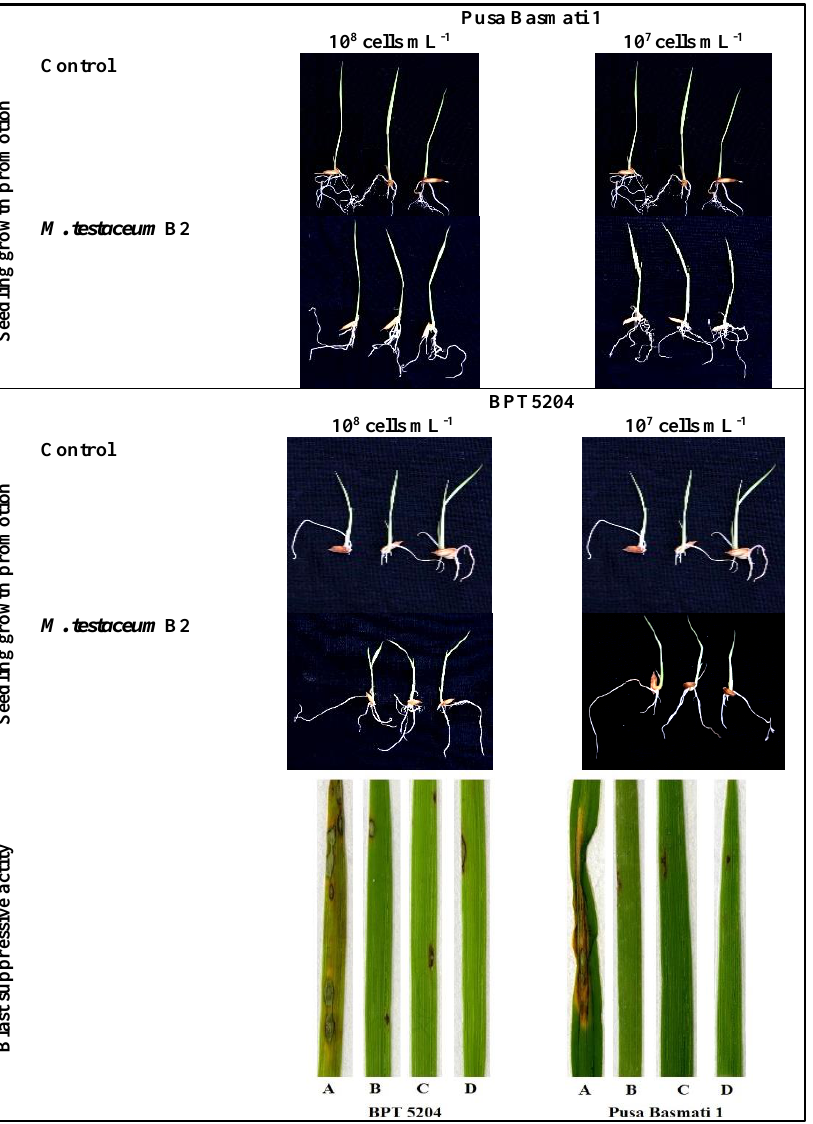
Figure 5. M. testaceum B2 induced growth promotion in rice seedlings and blast disease suppressive activity. M. testaceum stimulated the growth of rice seedlings upon bacterization; the number of lesions and size of lesions were found to be reduced in bacterized plantlets; plant responses are scored as per Mackill and Bonnman [37]. ( A ) Control ( B ) M. testaceum B2 (10 8 CFU mL − 1 ). ( C ) M. testaceum B2 (10 7 CFU mL -1 ).(D)Tricyclazole.